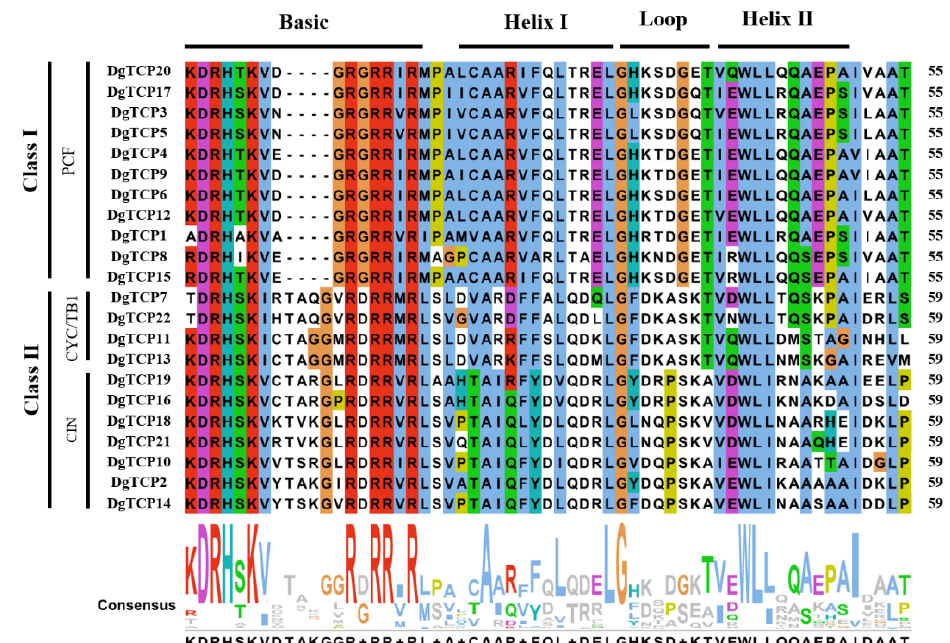
Figure 2. The logo and sequence alignment of TCP domains from orchardgrass. The basic helix–loop–helix structure has been marked.